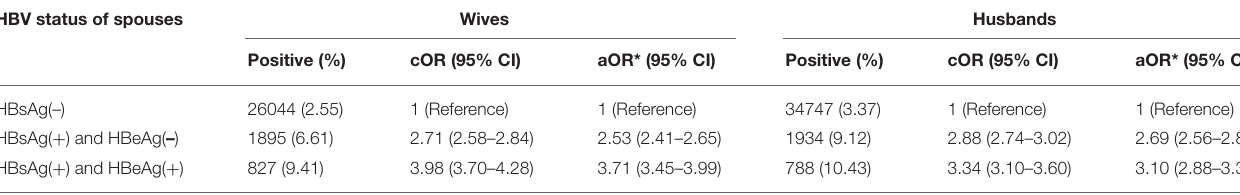
TABLE 3 | Association between HBV status of spouses and HBsAg status of wives/husbands. HBV status of spouses Wives